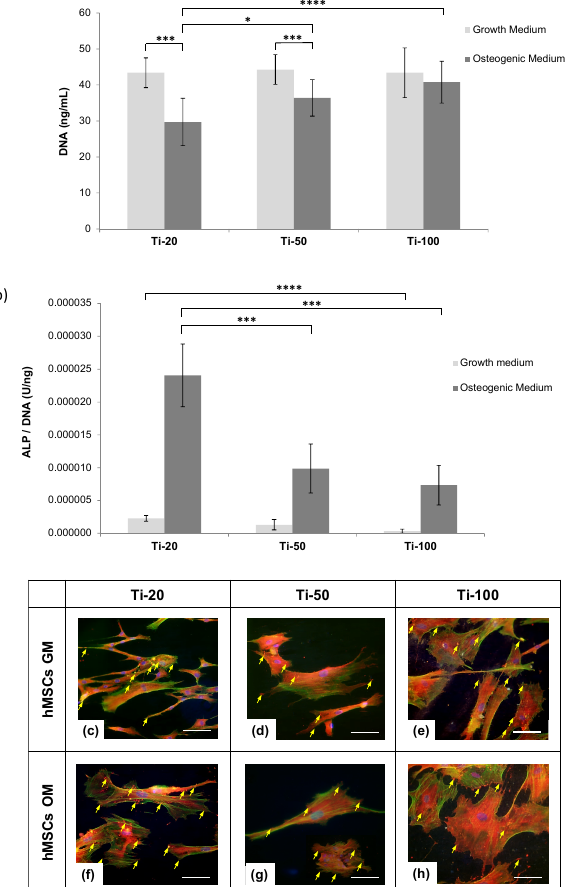
Figure 3. ( a ) DNA content of human mesenchymal stem cells (hMSCs) measured using PicoGreen assay, cultured on anodised titanium samples with respective pore diameter at Day 14 in growth medium (GM) and osteogenic medium (OM). Values are mean ± S.D., n = 4, * p < 0.05, *** p < 0.005, **** p < 0.001; ( b ) Normalised alkaline phosphatase (ALP) activity per DNA of human mesenchymal stem cells (hMSCs) cultured on anodised titanium samples with respective pore diameter at Day 14 in growth medium (GM) and osteogenic medium (OM). Values are mean ± S.D., n = 4, *** p < 0.005, **** p < 0.001; ( c – h ) Immunofluorescence microscopy with cell nuclei (blue), F-actin cytoskeleton (green) and vinculin (red) of human mesenchymal stem cells (hMSCs) cultured on anodised titanium samples with respective pore diameter at Day 14 in growth medium (GM) and osteogenic medium (OM). Yellow arrows indicate the focal adhesion sites. Scale bar = 100 µm.